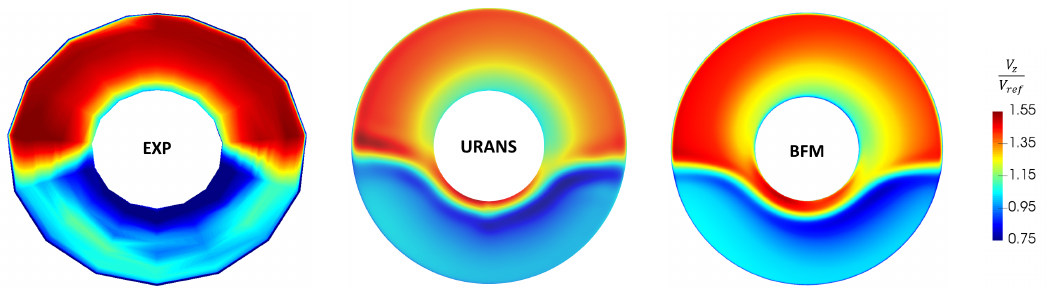
Figure 16. Axial velocity field in Section 2.